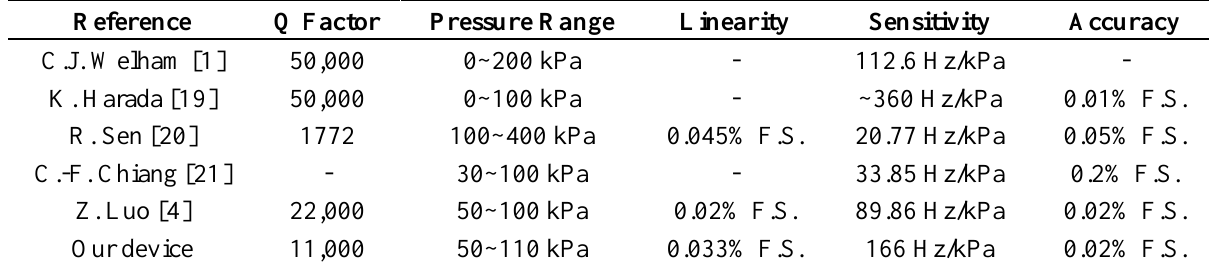
Table 1. A comparison of device performance based on